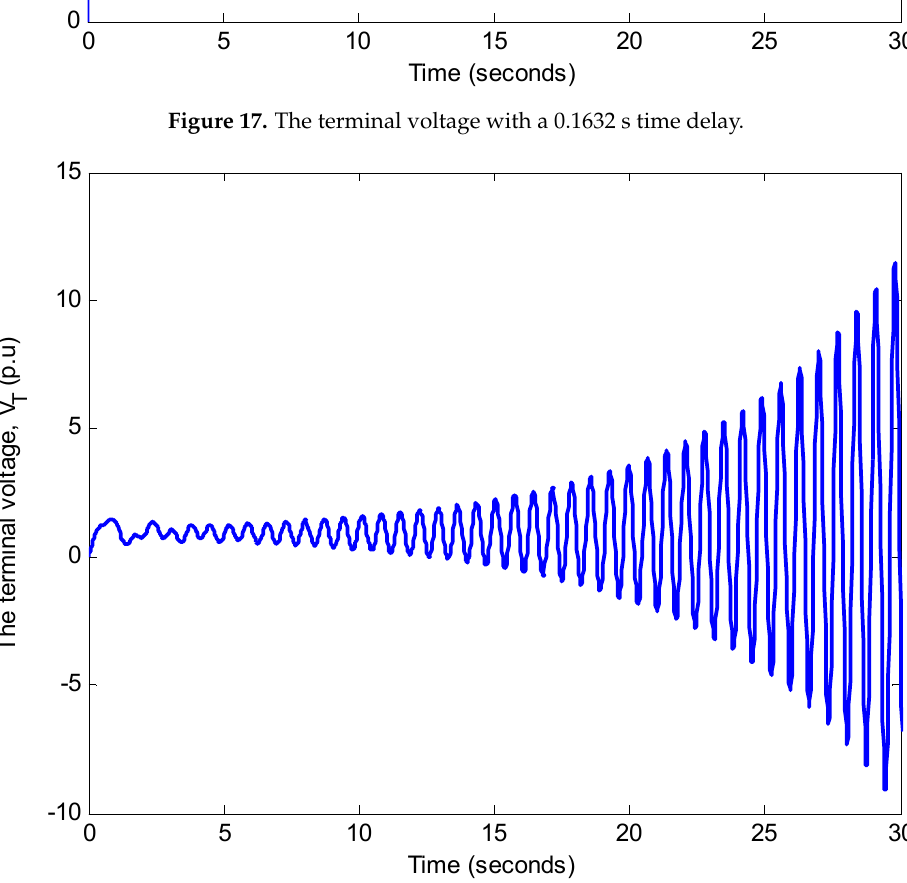
Figure 19. The terminal voltage with a 0.3744 s time delay.